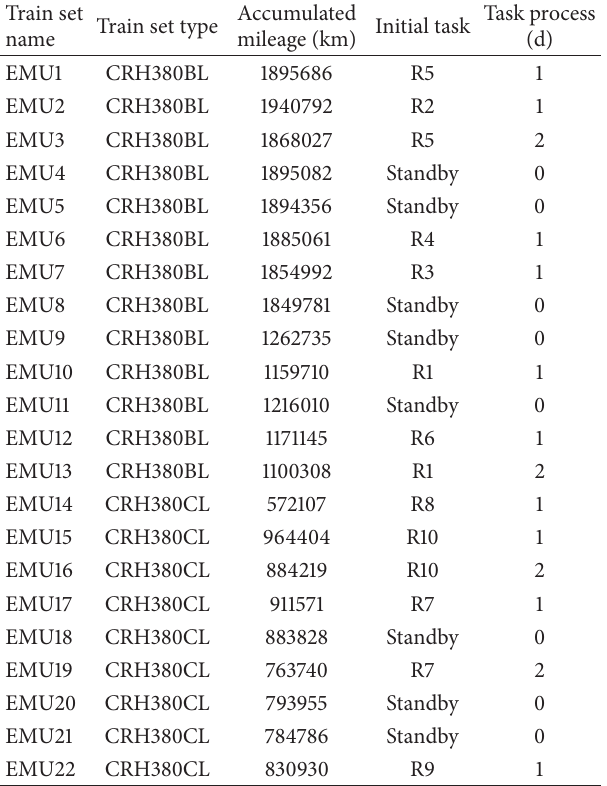
Table 2: Basic information of motor train sets. Train set